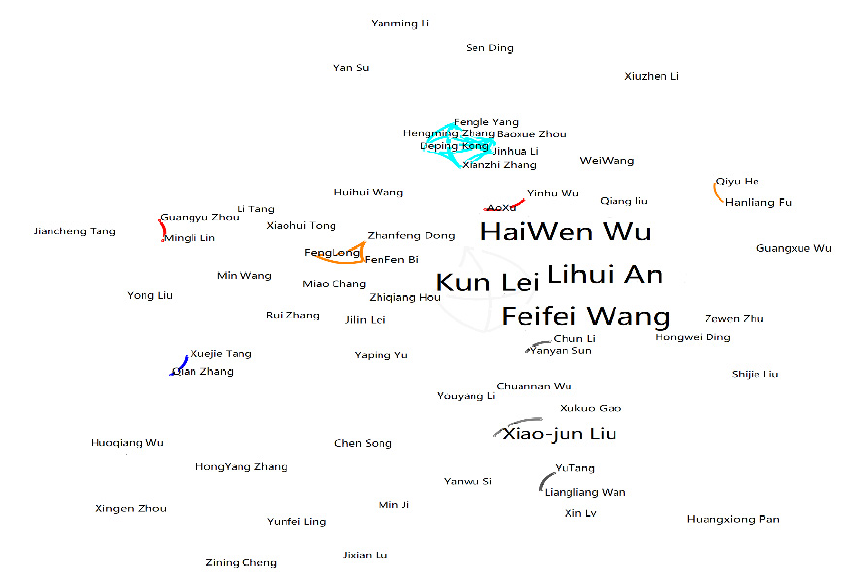
Figure 4. Cooperation chart of domestic authors.